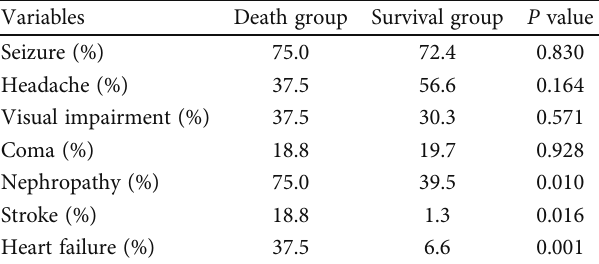
Table 2: Comparison of clinical